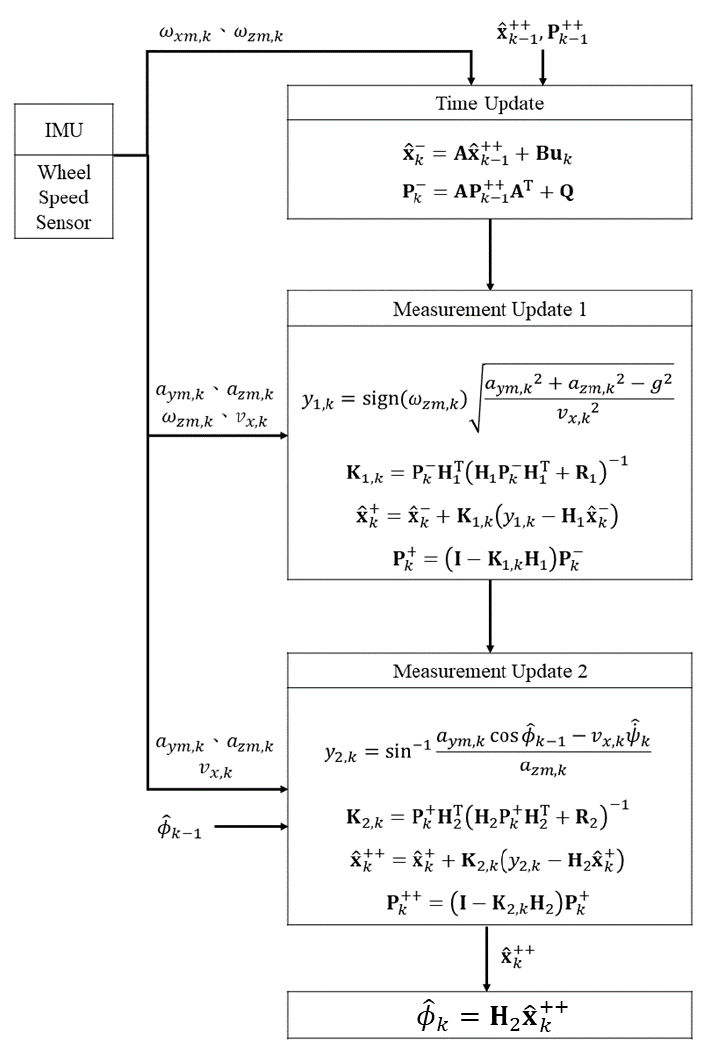
Figure 3. Flow chart for estimating the roll angle.